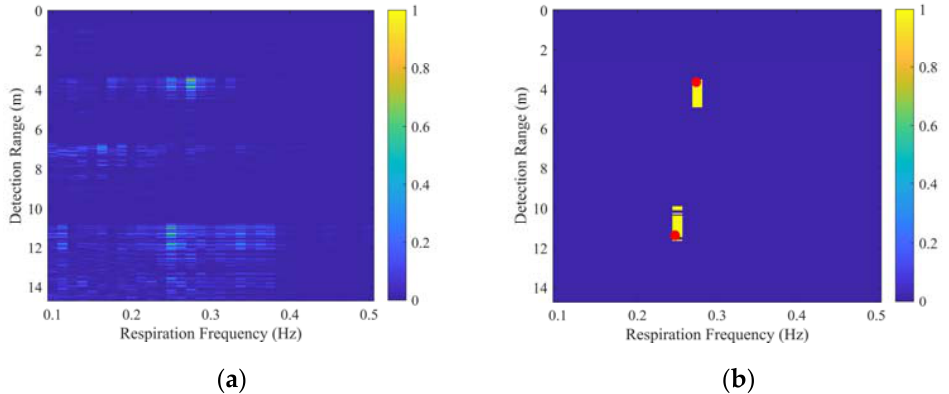
Figure 13. Comparison result processed by the method in [35] of the experiment with multiple targets: ( a ) range-frequency matrix used for detection; ( b ) result extracted by the 2D CFAR energy windows.